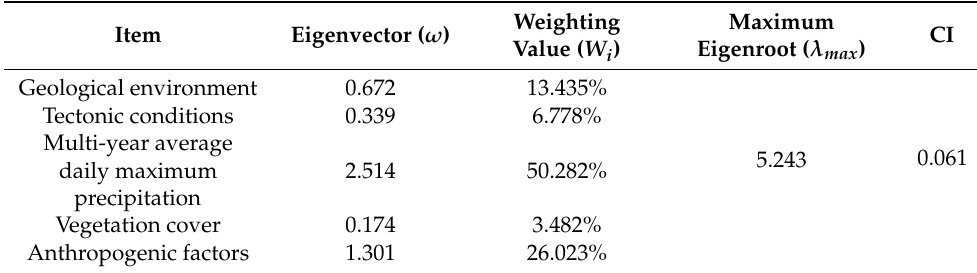
Table 4. AHP Hierarchical analysis